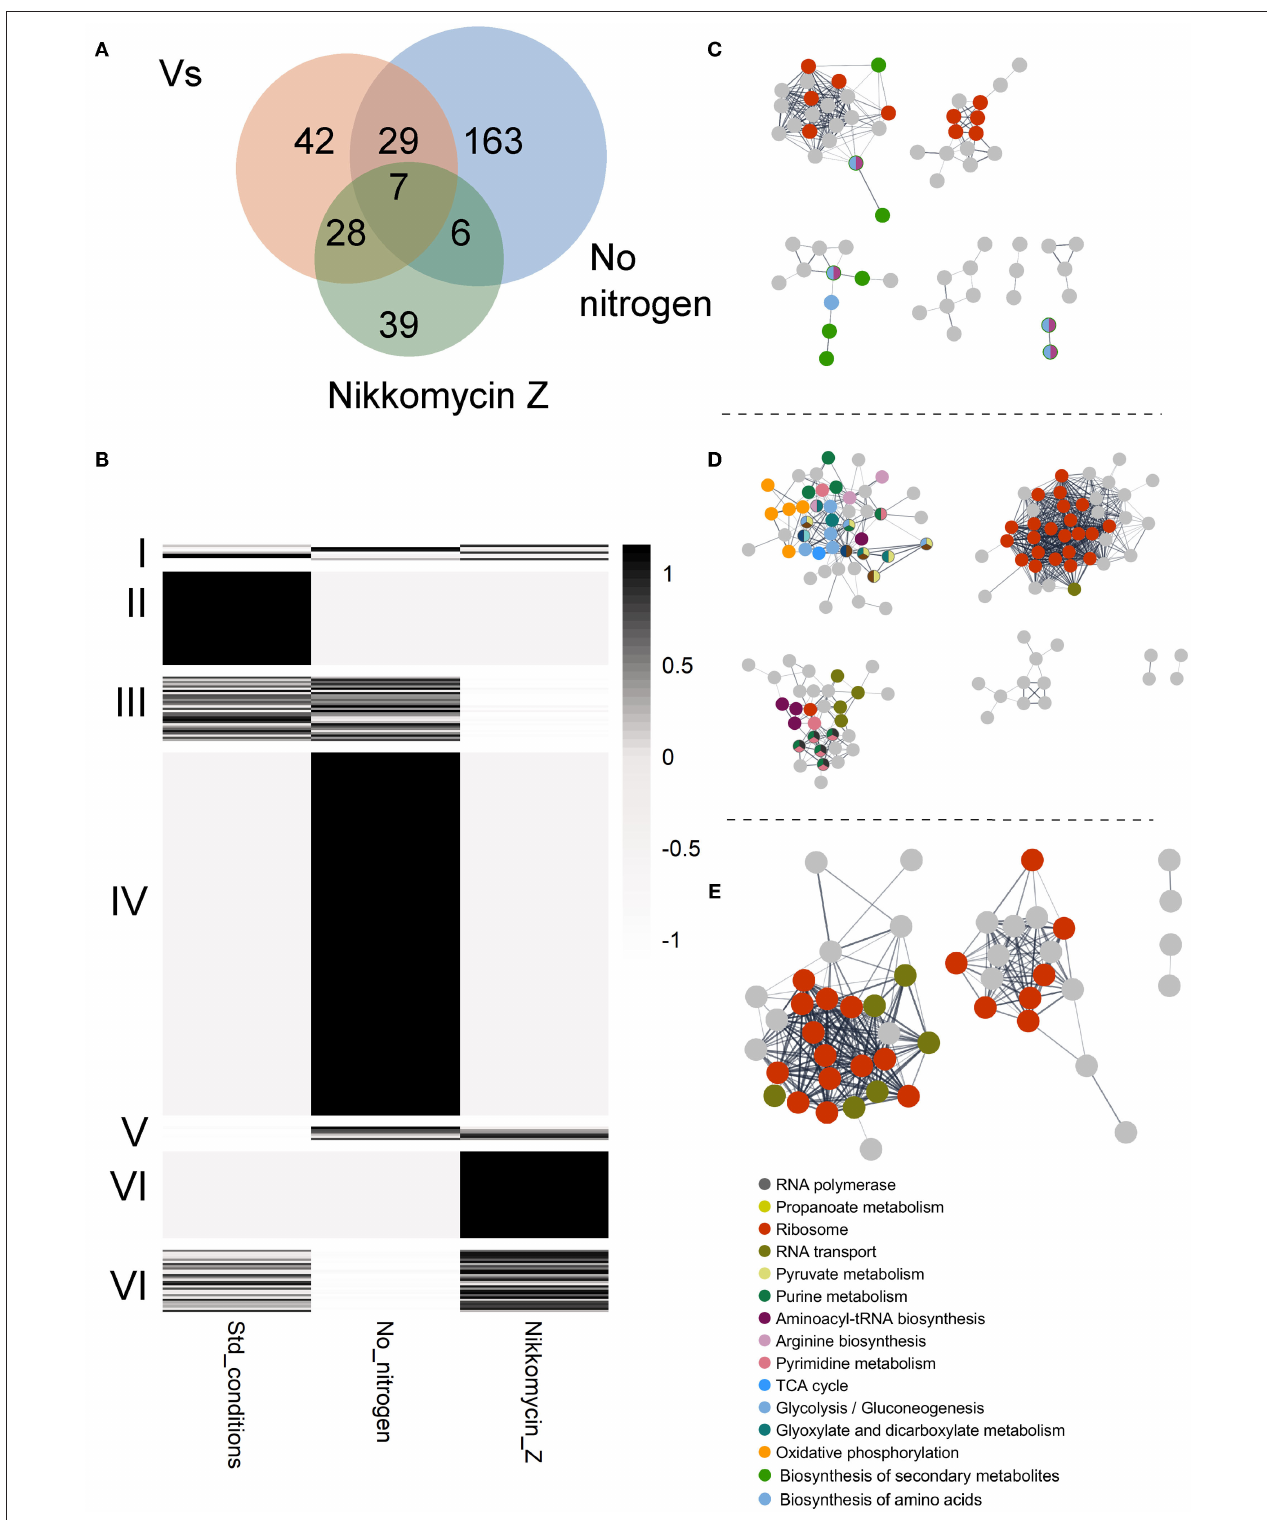
FIGURE 3 | GUL-1 interacts with multiple proteins. (A) VENN diagram of specific or shared enriched proteins, associated with the tested treatments. (B) A heatmap presenting the average scaled ( z -score) enrichment, by –log 10 P -value of GUL1 co-immunoprecipitation proteins. The enriched proteins were annotated based on KEGG categories. The proteins were clustered by (I) enrichment for all three treatments, (II) exclusive enrichment in GUL-1 under standard growth conditions,